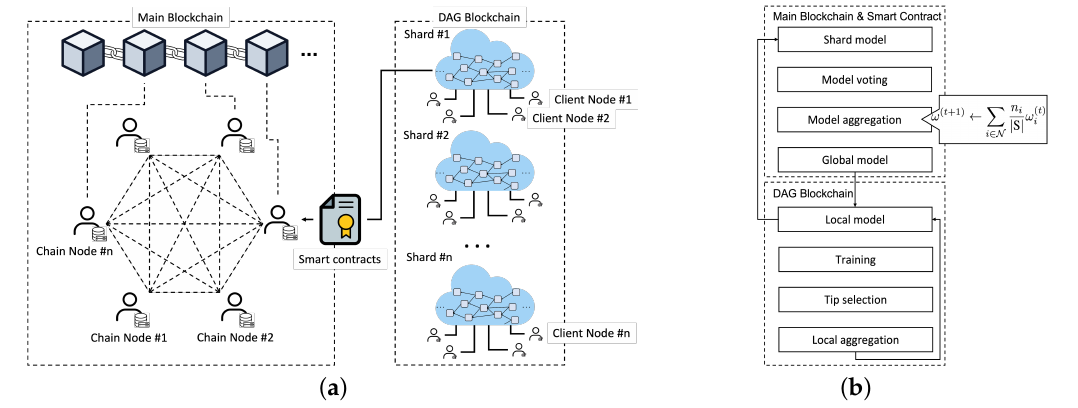
Figure 1. System architecture and flow. ( a ) System architecture for federated learning with hierarchi- cal blockchains; ( b ) System flow of hierarchical